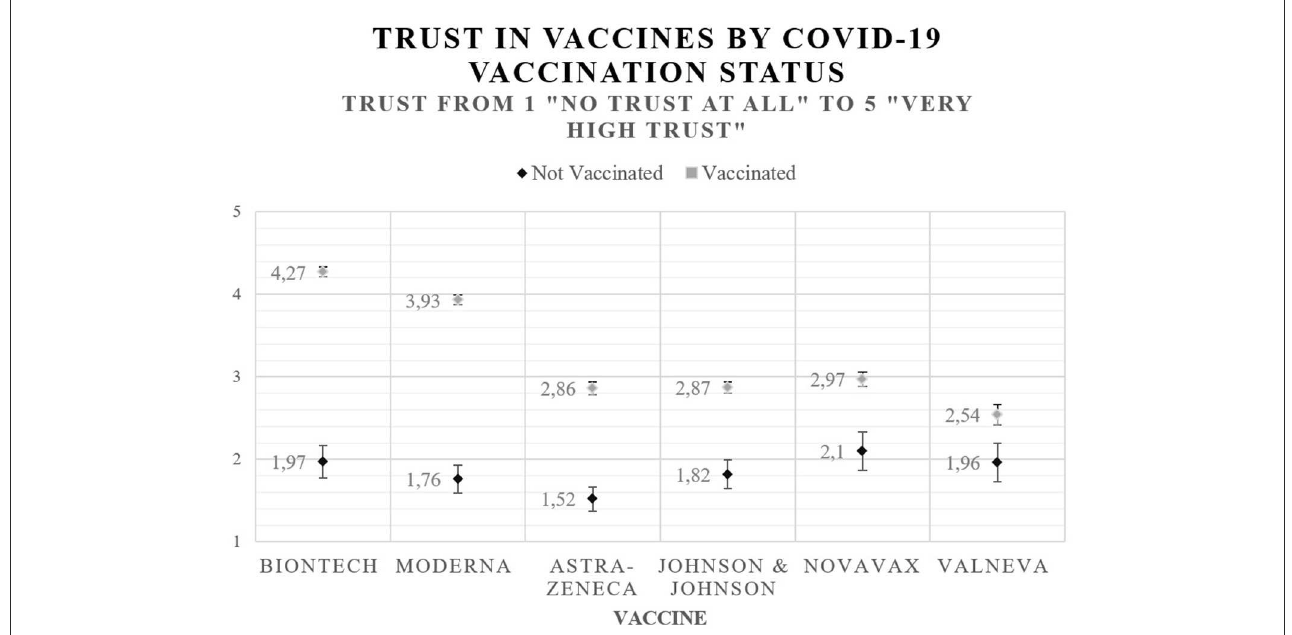
FIGURE1 Trust in COVID-19 vaccines.